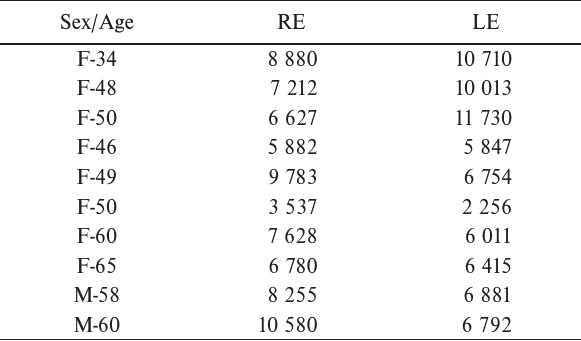
Table 2. The table shows the fMRI values in the control